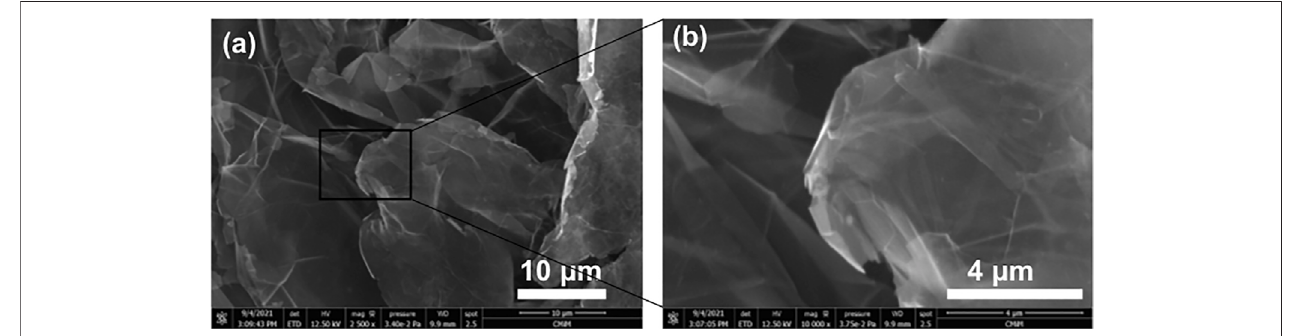
FIGURE 2 | Graphene sheet particles used as additive the lubricant.